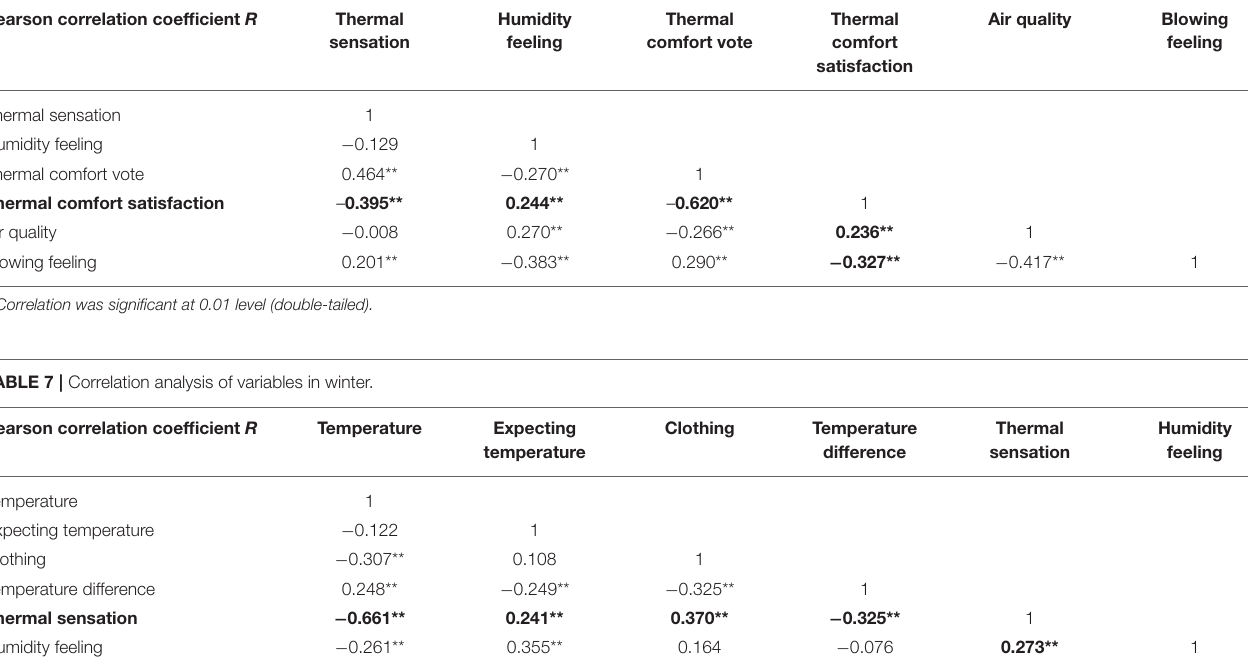
Figure 5A is the sensor arrangement in the 4# room of a female apartment to test the temperature and the relative humidity in vertical directions, the CO 2 concentration, and the